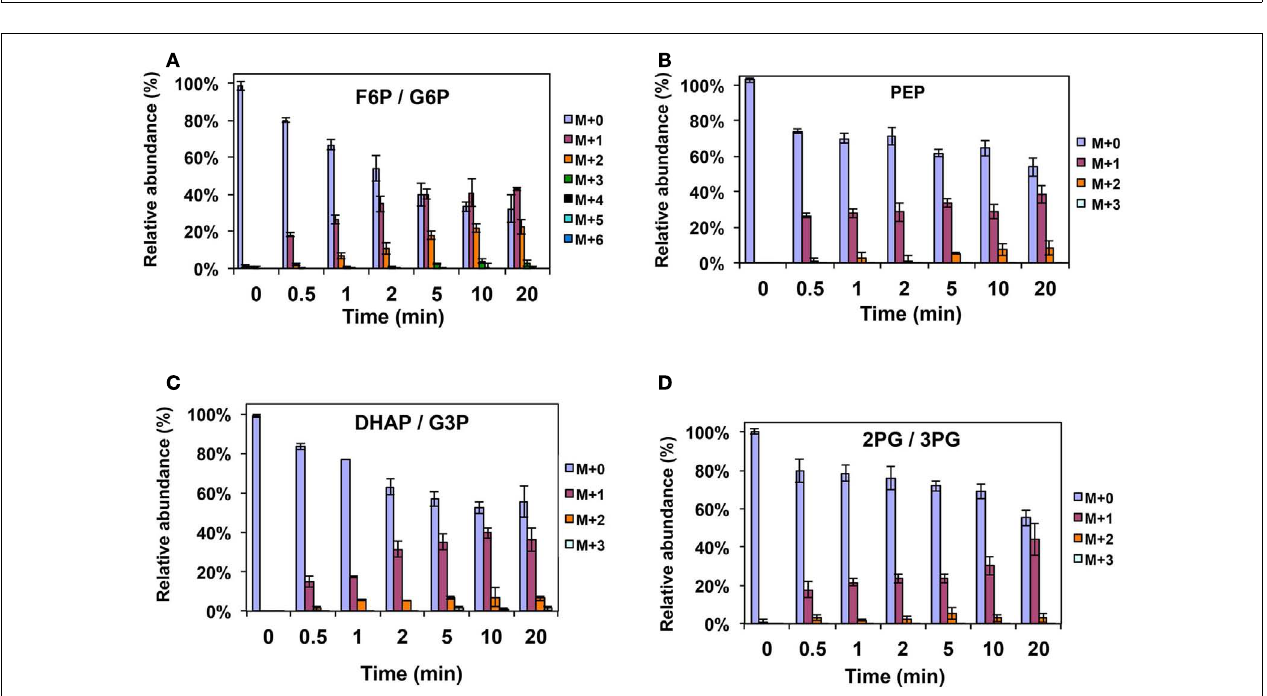
FIGUREA2 | 13 C-incorporation during 12 CO 2 spiking in Methylosinus trichosporium OB3b grown on 12 CH 4 . 12 C/ 13 C-isotopomer distributions of fructose-6-phosphate/glucose-6-phosphate (A) , phosphoenolpyruvate (B) , dihydroxyacetone phosphate/glyceraldehyde 3-phosphate (C) , 2-phosphoglycerate/3-phosphoglycerate (D)